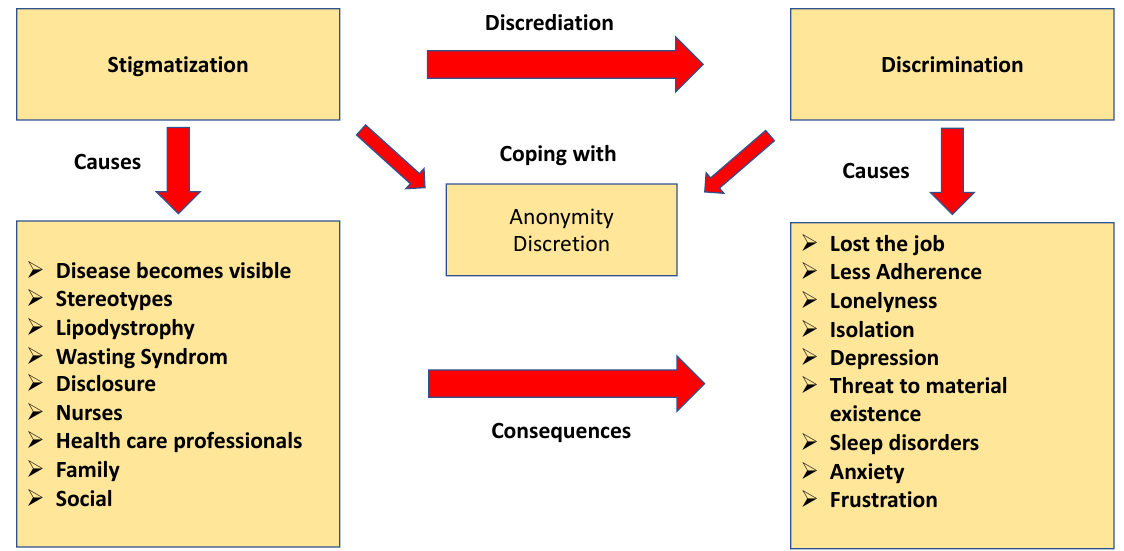
Figure 3. Stigmatization and discrimination (own presentation).